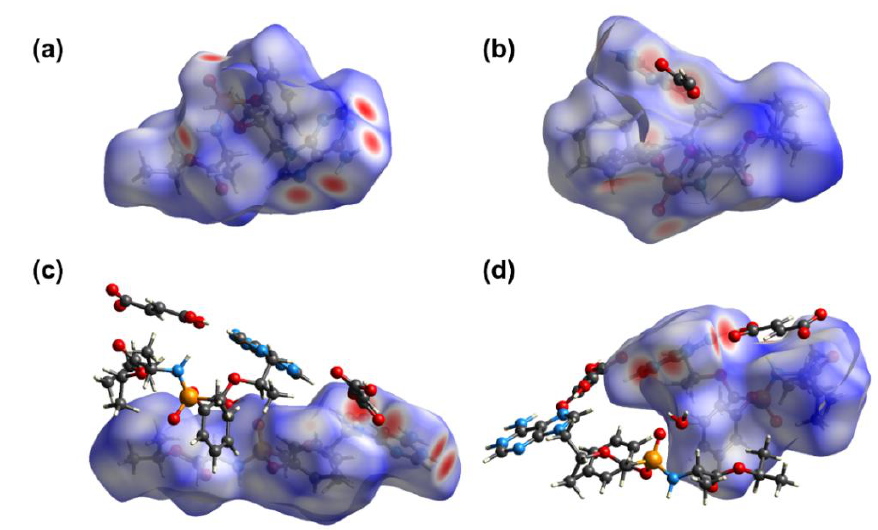
Figure 7. Hirshfeld surfaces for the TAF with its neighboring molecules in the crystals of ( a ) pristine TAF, ( b ) 1 , and ( c , d ) 2 , showing that two fumarate molecules in 2 were attached to one adenine ring at two different sites via hydrogen bonding.